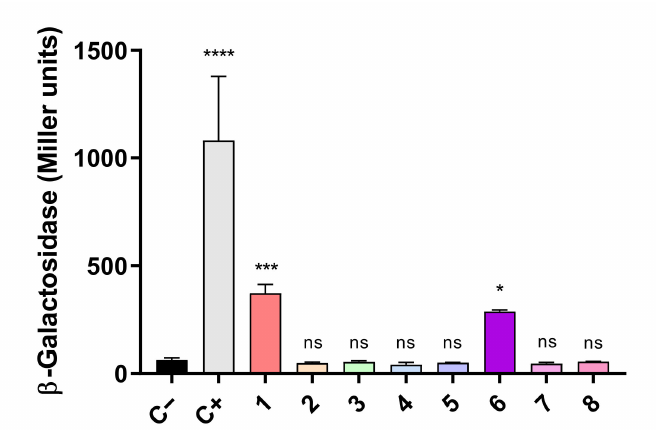
Figure 2. Bacterial two-hybrid assays between FurA and Thioredoxin A. In vivo interaction between FurA and TrxA was quantified by measuring β -galactosidase activities in E. coli BTH101 cells harboring a pair of compatible plasmids with corresponding genes fused with the T25 or T18 adenylate cyclase domains: 1: pKNT25- trxA + pUT18- furA ; 2: pKNT25- trxA + pUT18C- furA ; 3: pKT25- trxA + pUT18- furA ; 4: pKT25- trxA + pUT18C- furA ; 5 pUT18- trxA + pKNT25- furA ; 6: pUT18- trxA + pKT25- furA ; 7 pUT18C- trxA + pKNT25- furA ; and 8: pUT18C- trxA + pKT25- furA. Empty pKT25 and pUT18C served as negative controls (C − ), whereas pKT25-zip and pUT18C-zip served as positive controls (C+). The β -galactosidase activity represents the averages ± standard deviation of three biological replicates. All β -galactosidase activity values were subjected to a one-way analysis of variance (ANOVA) test with respect to the negative control (C − ) to determine if values were significant ( ns not significant, * p < 0.05, *** p < 0.001, **** p <